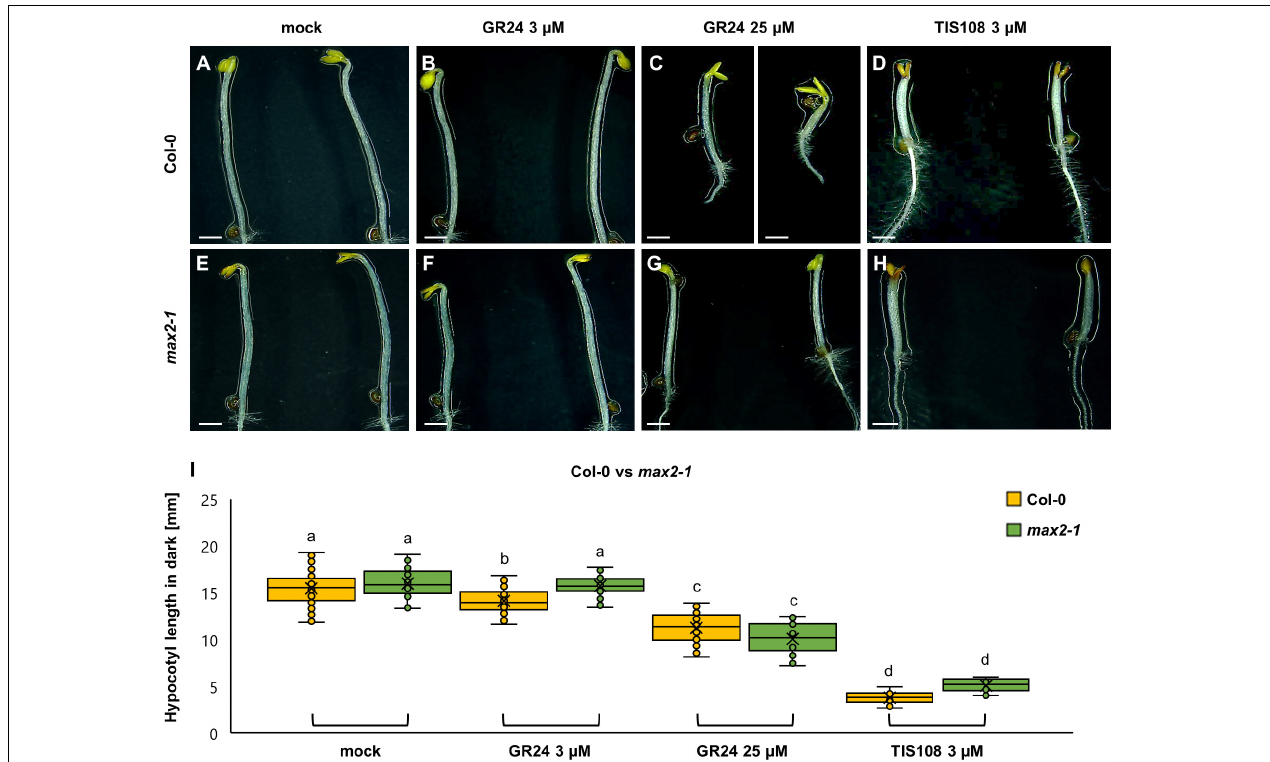
FIGURE 2 | Hypocotyl development of dark-grown seedlings of Arabidopsis Col-0 or the max2-1 mutant in the presence or absence of the synthetic strigolactone GR24 (3 µ M and 25 µ M) or the biosynthetic inhibitor of strigolactone production TIS108 (3 µ M). (A–D) Overview of the etiolated hypocotyl of Col-0 seedlings treated with solvent alone (mock) (A) , 3 µ M GR24 (B) , 25 µ M GR24 (C) , and 3 µ M TIS108 (D) . (E–H) Similar overview of hypocotyls of etiolated max2-1 mutant seedlings in the presence of mock (E) , 3 µ M GR24 (F) , 25 µ M GR24 (G) , 3 µ M of TIS108 (H) . (I) Quantitative assessment of etiolated Col-0 and max2-1 hypocotyl length comparing pairwise mock treatment and treatments with 3 µ M GR24, 25 µ M GR24, and 3 µ M TIS108 ( N ≥ 22; two-way ANOVA was followed with Scheffé’s test; a statistical comparison is shown within the groups sharing the same genotype; letters in the graph are shared by groups without statistically significant differences at the 0.001 probability level; results are in Supplementary Table 3 ). In all box plots, the average is presented by × , median by the middle line, 1 st quartile by the bottom line, 3 rd quartile by the top line; the whiskers lie within the 1.5 × interquartile range (defined from the 1 st to the 3 rd quartiles), while outliers are omitted. Scale bars: 10 mm (A–H)